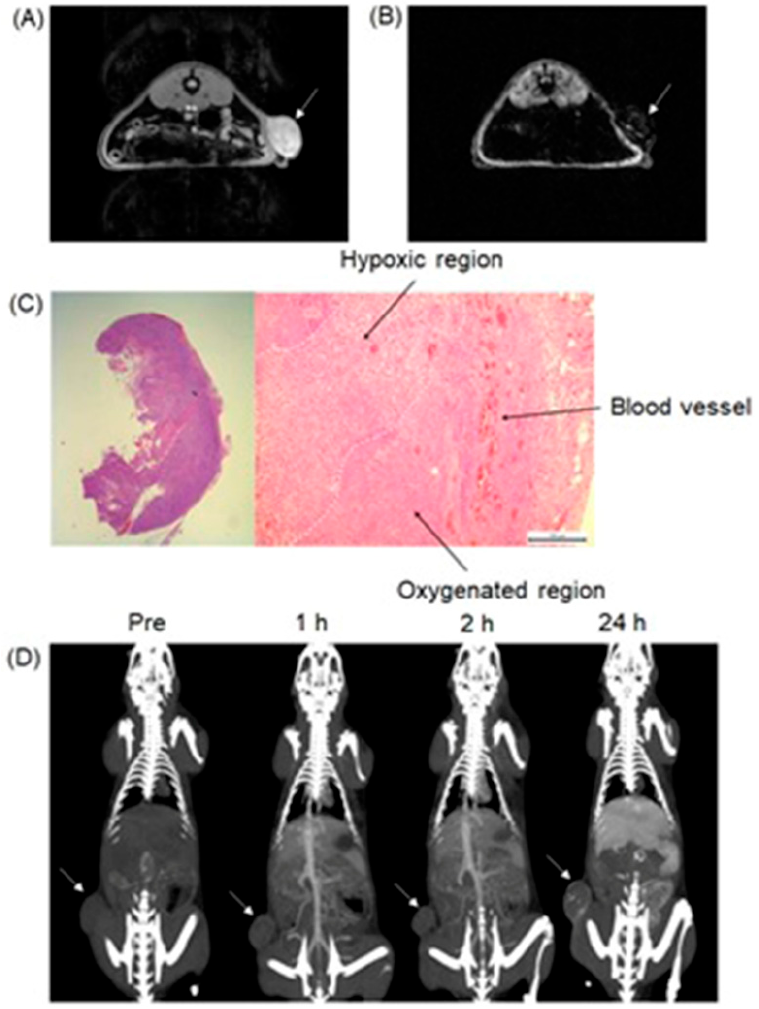
Figure 10. T 2 -weighted MRI image ( A ) before and ( B ) after intravenous injection of the Fe 3 O 4 /TaO x core/shell nanoparticles prepared at a concentration 0.4 mg/mL Fe 3 O 4 . Tumor site indicated in a white arrow. ( C ) Hematoxylin and eosin-stained section of the tumor. Whole-tumor image (left) shows that the interior is inhomogeneous. Magnified image (right) of tumor shows hypoxic region, oxygenated region, and blood vessel. Scale bar represents 200 µ m. ( D ) Coronal maximum intensity projection images of whole-body X-ray CT images of a rat before and after intravenous injection of Fe 3 O 4 /TaO x core/shell nanoparticles. White arrows indicate the tumor site. Adapted with permission from Lee, N.; Cho, H. R.; Oh, M. H.; Lee, S. H.; Kim, K.; Kim, B. H.; Shin, K.; Ahn, T.